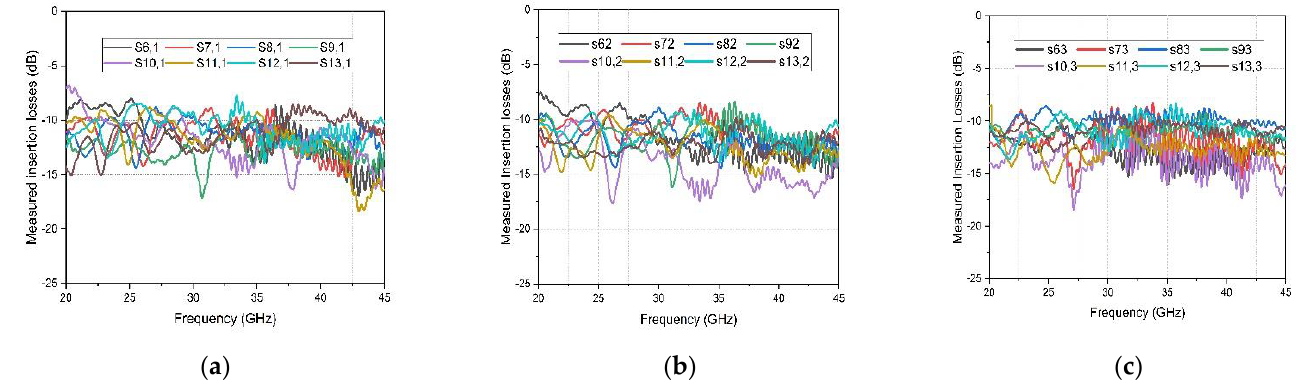
Figure 10. Measured insertion losses of the fabricated SICL-based RL at array ports when ( a ) beam port 1 is excited, ( b ) beam port 2 is excited, and ( c ) beam port 3 is excited.